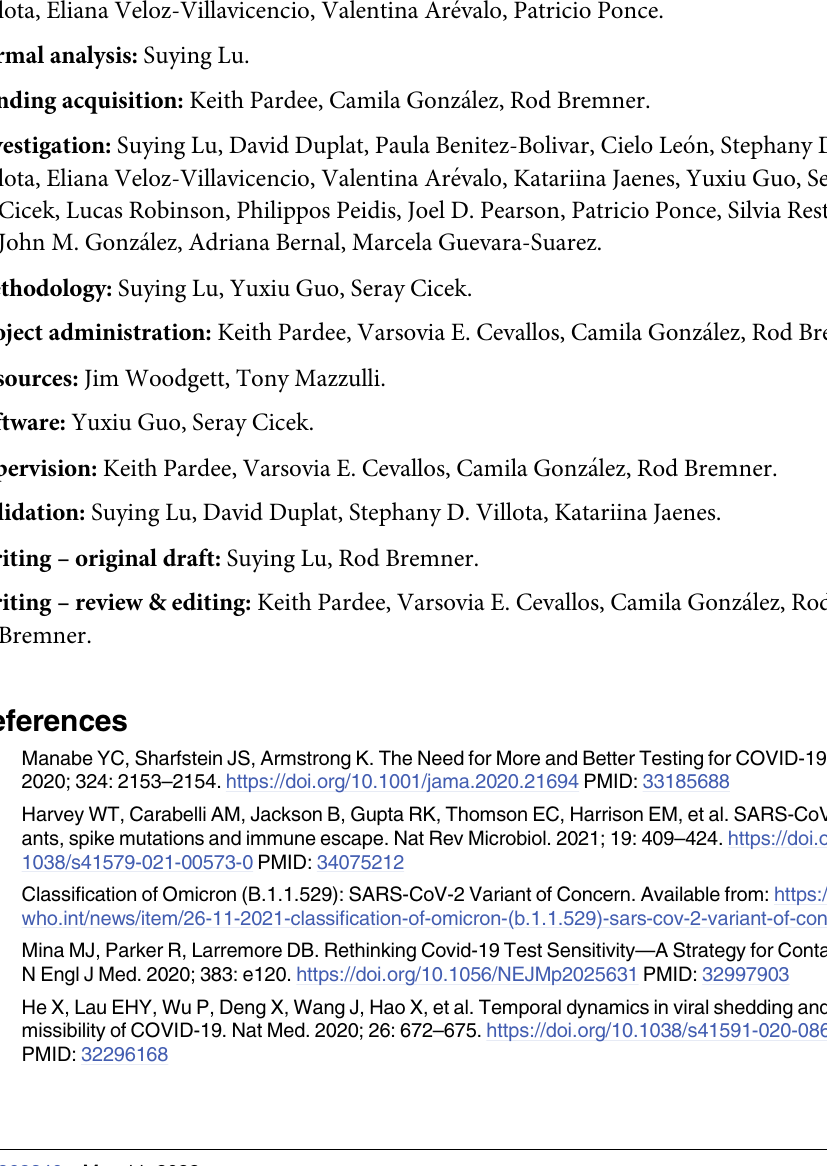
. A paired t-test was 20-40